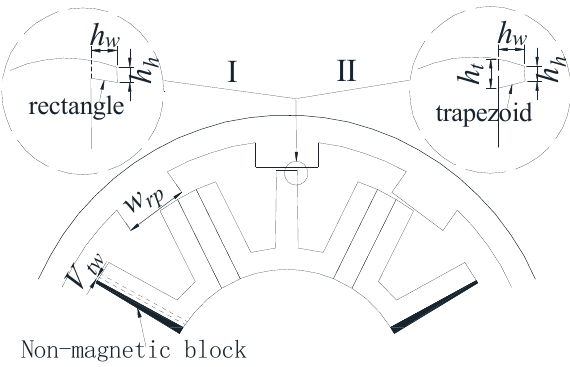
Figure 7. Main optimized parameters of 12S/10P MSOR-FSPM motor.